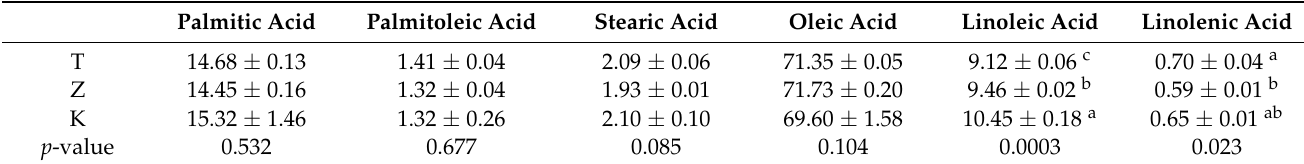
Table 3. Fatty acid profiles of the oils produced under different particle treatments (T = untreated control, Z = zeolitite, K = kaolin). Different letters in the same column indicate significant difference ( p < 0.05) according to Tukey’s honestly significant difference (HSD)